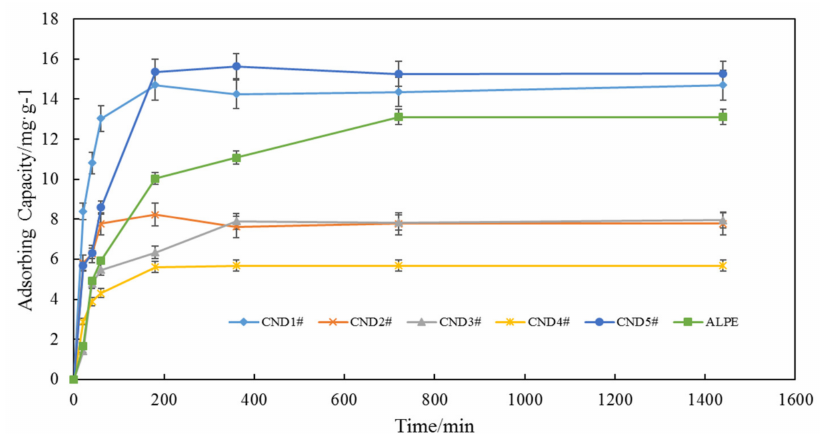
Figure 11. Adsorption amount of nanoemulsions with different oil phase content on rock surface.